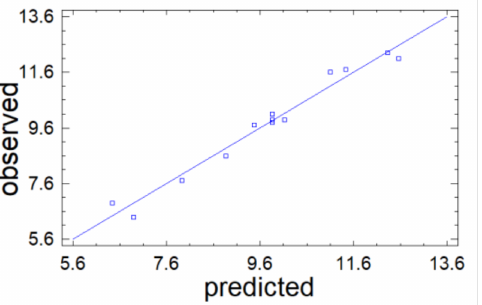
Figure 3. Results of observations vs. Y 1 values predicted by mathematical model (1).